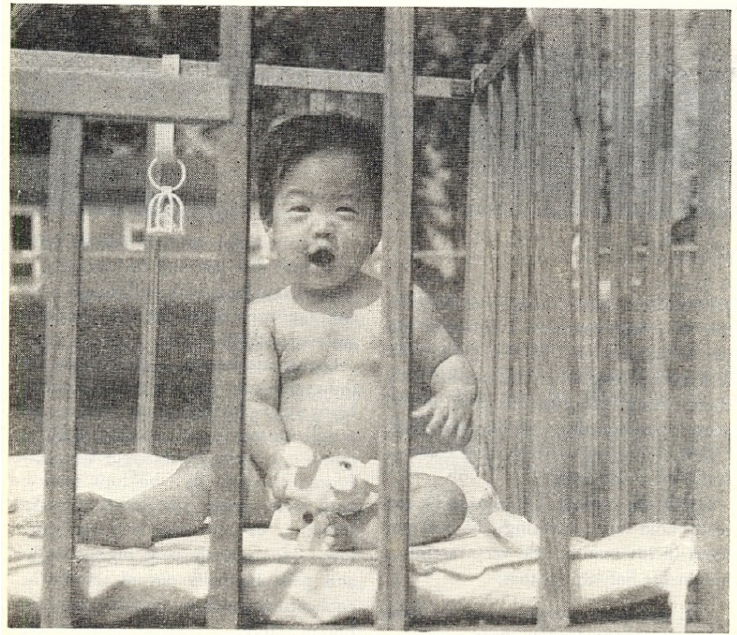
Figure 35. Photo of Asian-American Baby in Play Pen.